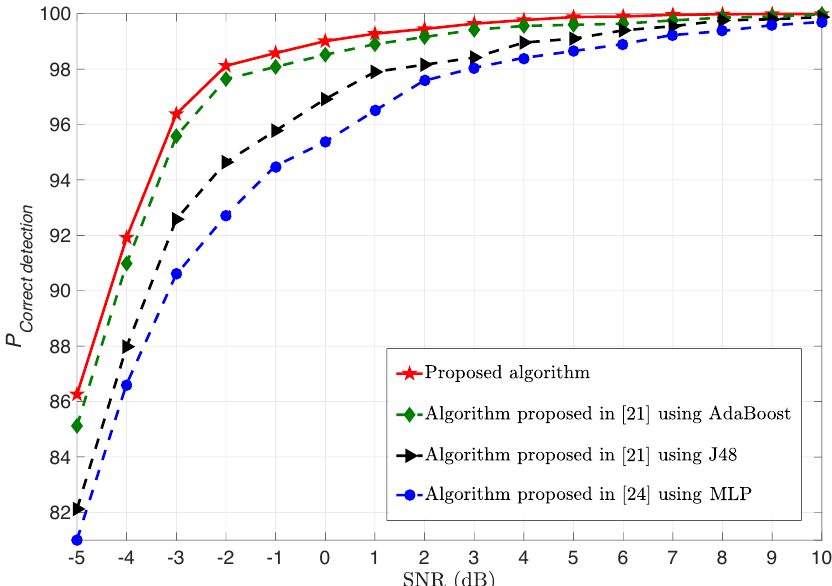
Figure 4. P Correctdetection as a function of SNR for the proposed algorithm using random committee compared to MLP [24], algorithm proposed in [21] using J48 MLT alone and AdaBoost operating with J48, where L = 3, N A = 4, SNR SR = 20dB, e 2 = 0.1, and | ρ | = 0.5.